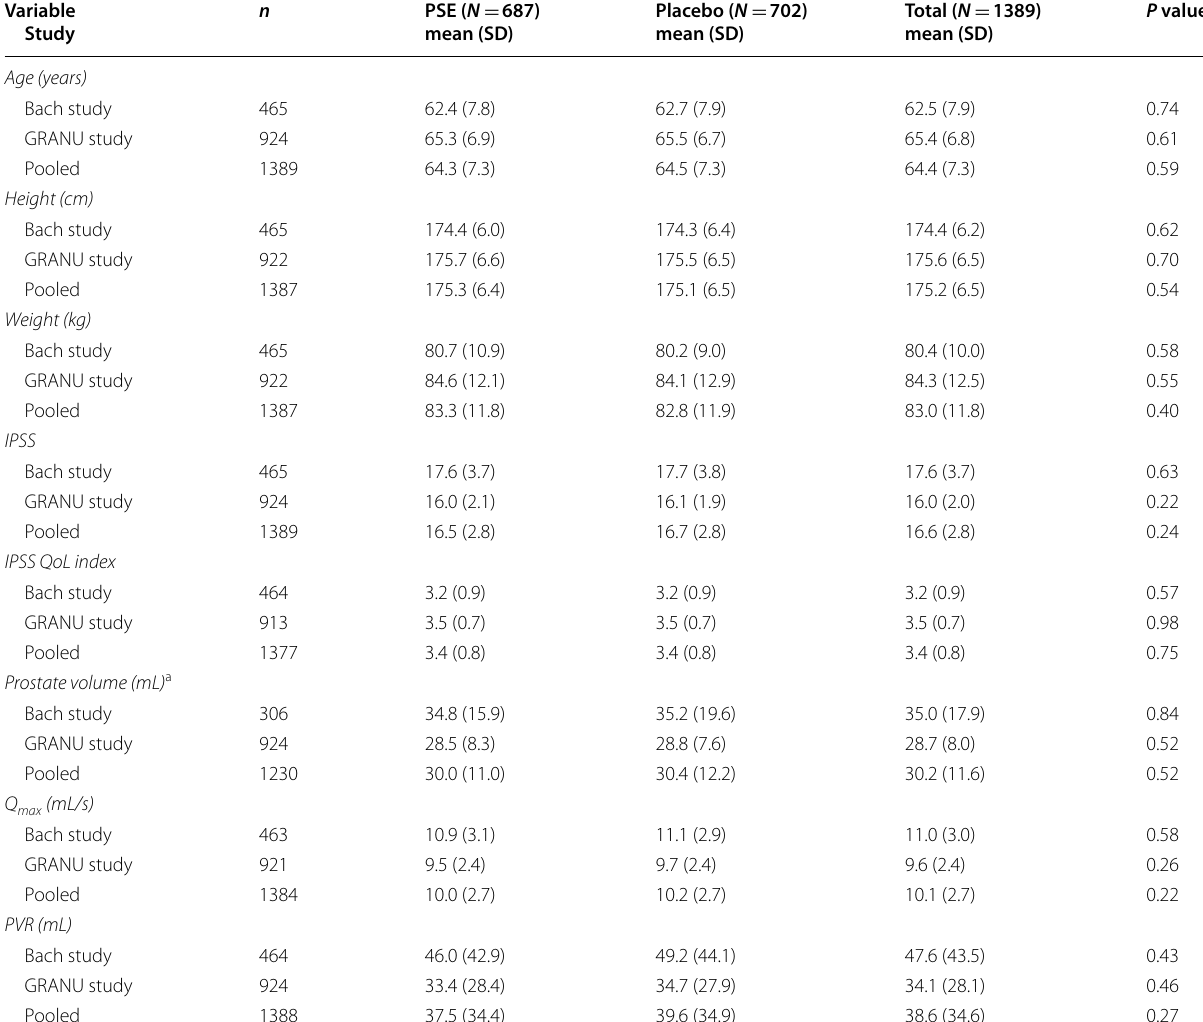
Table 2 Baseline demographic and disease characteristics (ITT set)